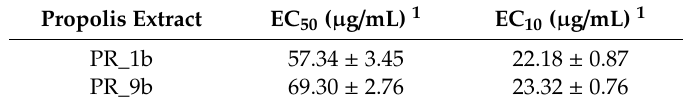
Table 5. The EC 50 and EC 10 values of the propolis extracts PR_1b and PR_9b.